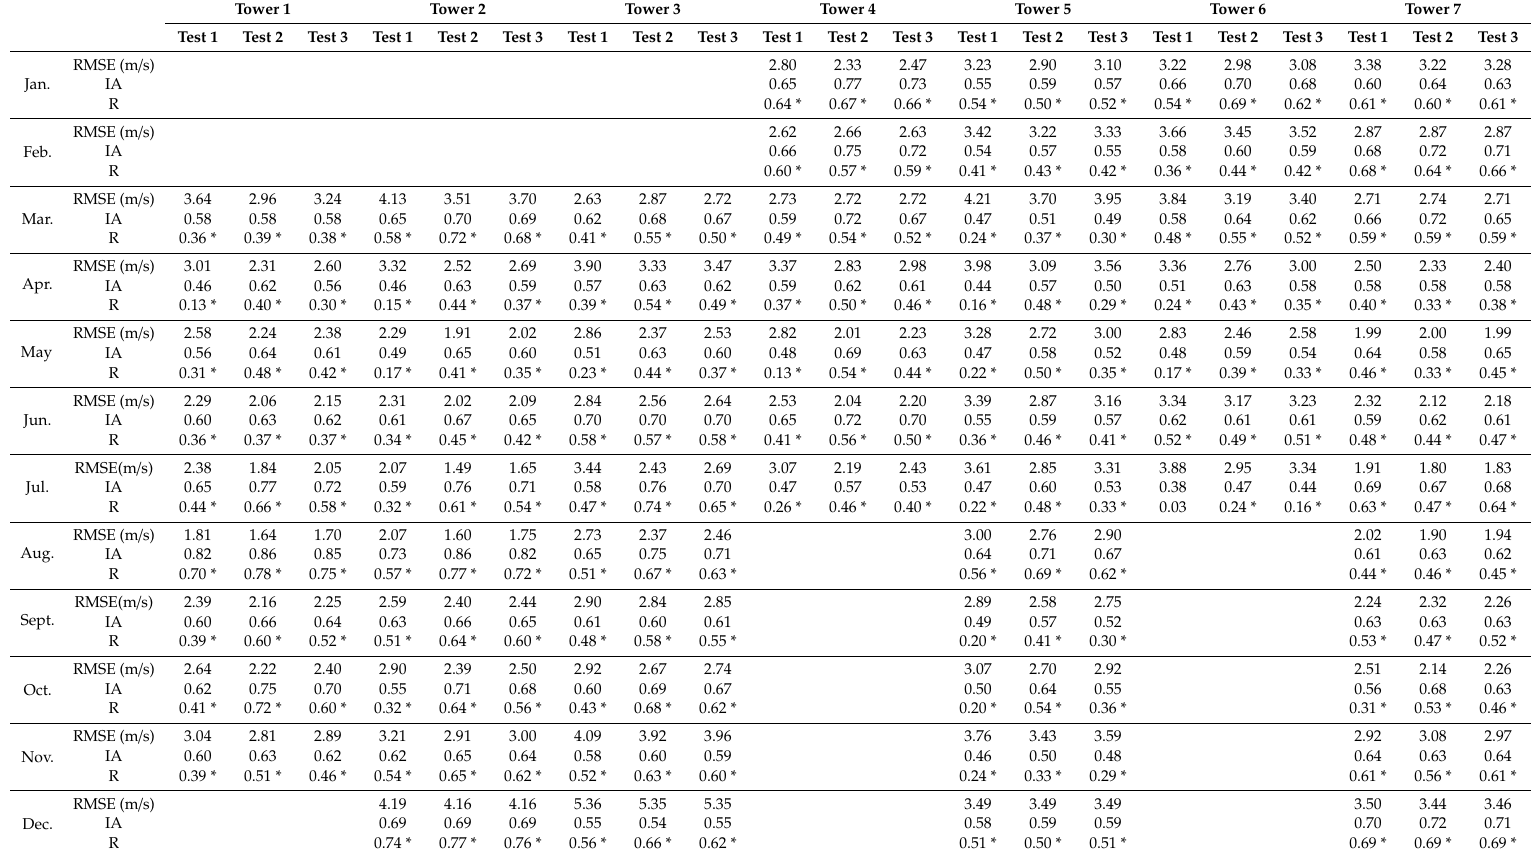
Table A1. Statistical results of Test 1, Test 2, and Test 3, at 10 m